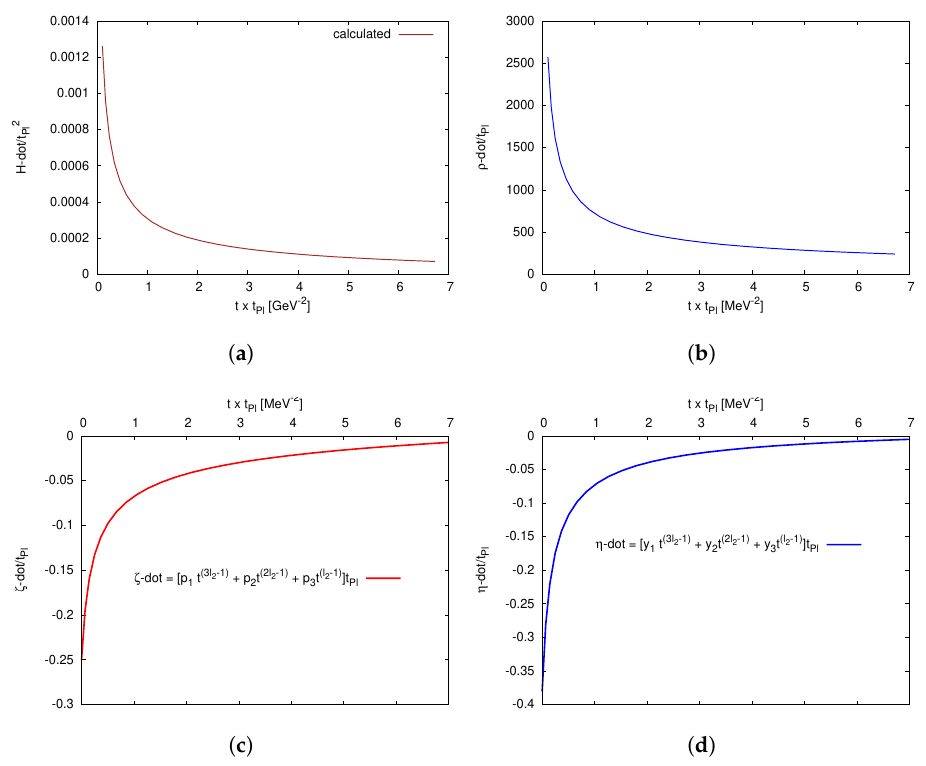
Figure 11. The time evolution of the cosmological parameters ˙ H , ˙ ρ , ˙ ζ , and ˙ eta are depicted in panels ( a – d ), respectively. Symbols refer to our calculations using Equations (6), (33), (36) and (38), respectively.